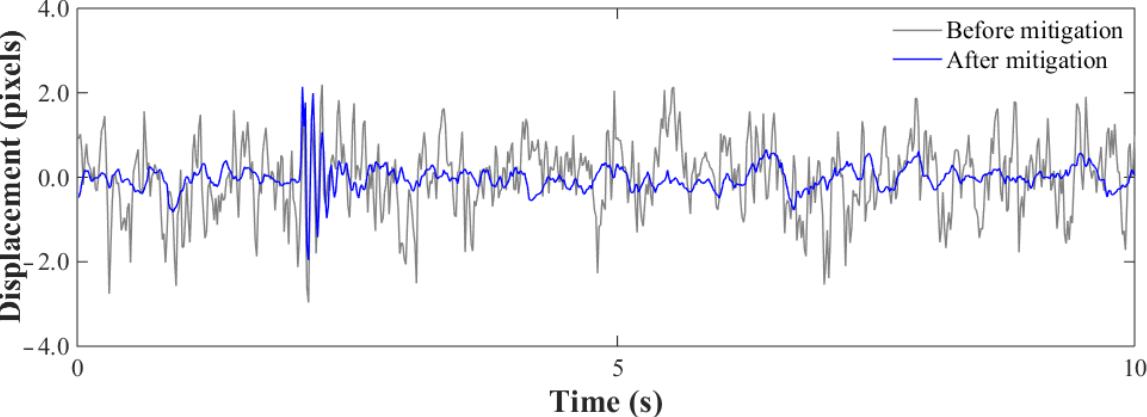
Figure 11. Displacement measurement results before and after optical-turbulence error mitigation.